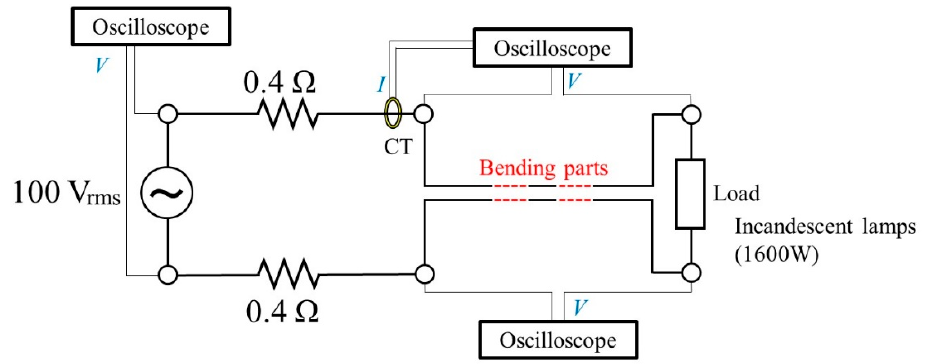
Figure 4. Experimental circuit for samples with the partially broken element conductors.